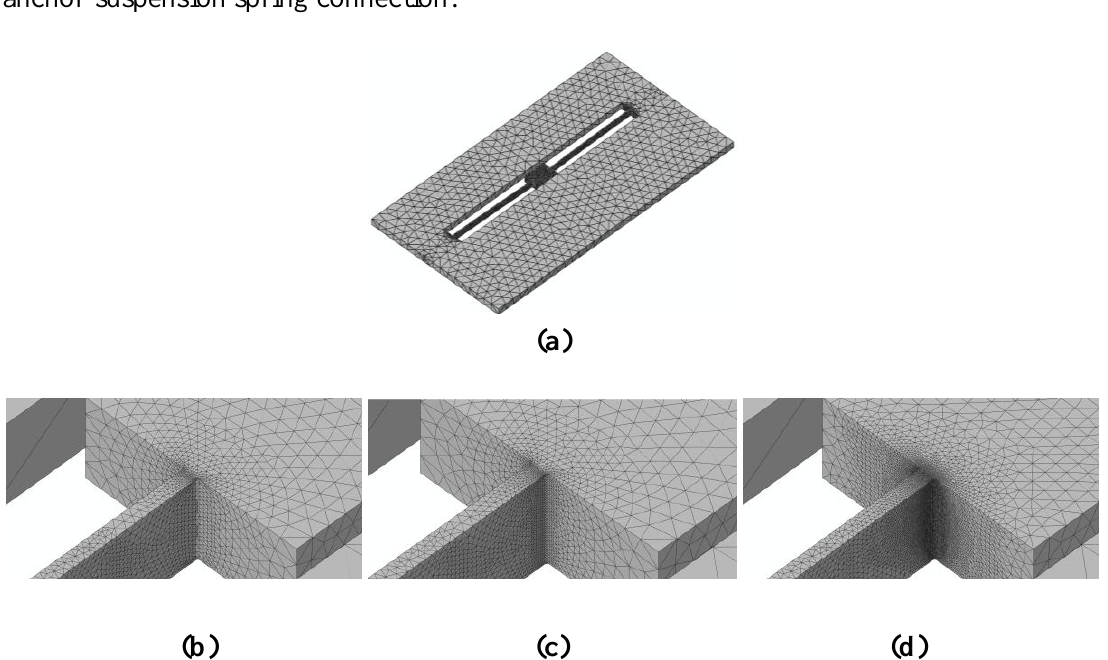
Figure 8. Adopted space discretizations: (a) overview of whole discretization; closed-up views of the meshes featuring (b) d anchor-suspension spring